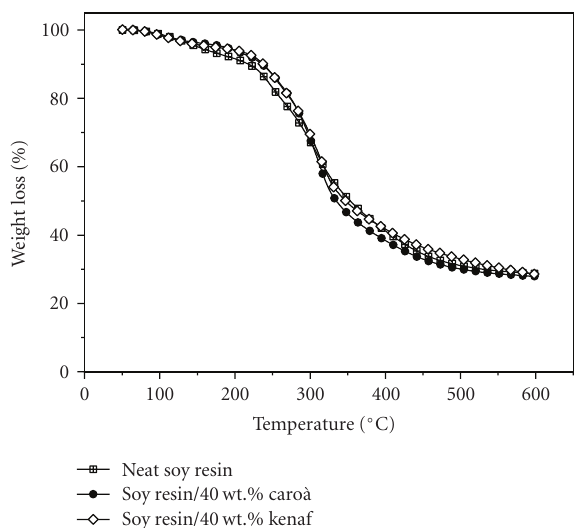
Figure 3: Thermogravimetric curves for soy-based systems.